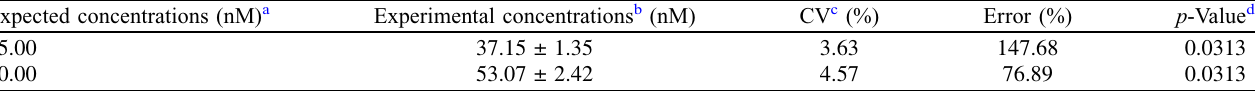
Table 1. Validation data of the standard curve using controls samples of fi xed artesunate concentrations. Expected concentrations (nM) a